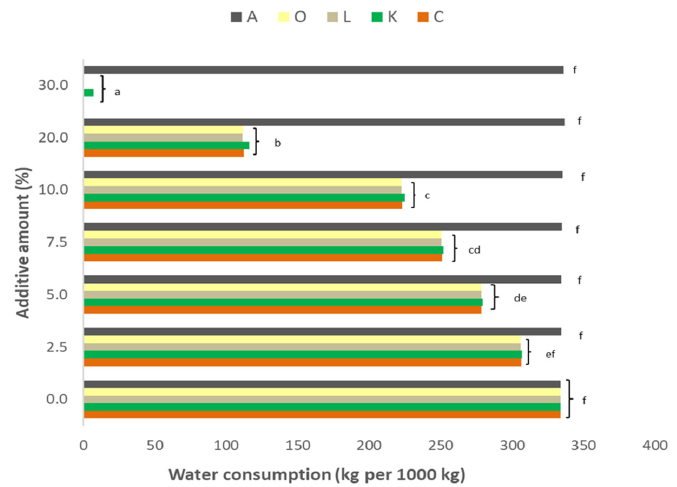
Figure 1. The effect of the additive level on water consumption during the extrusion-cooking of potato snack pellets with addition of fresh vegetables: A—Control without additives, O—Onion, L—Leek, K—Kale, C—Carrot; a–f Means followed by the same letters do not differ significantly at α = 0.05.